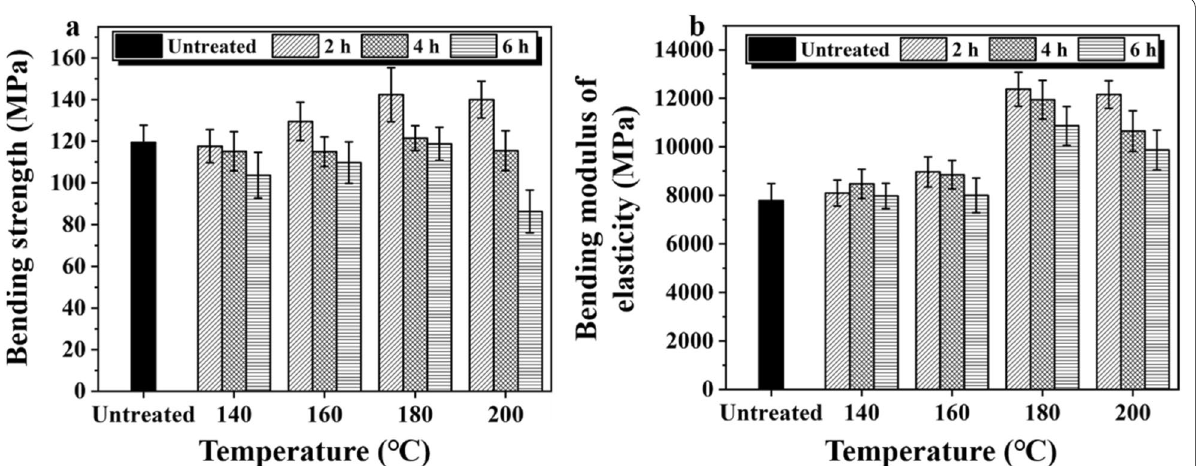
Fig. 8 The bending strength and the MOE of untreated sample and the treated samples at varied temperature (140, 160, 180 and 200 °C) for varied time (2, 4 and 6